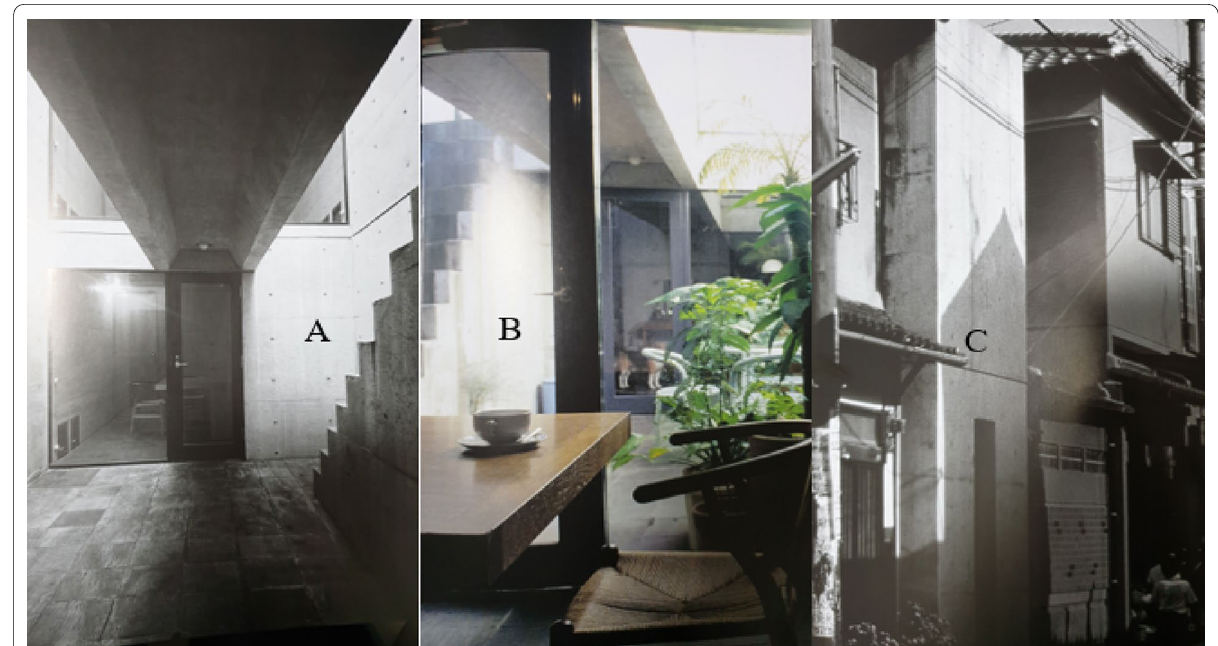
Fig. 2 Row House Sumiyoshi, Osaka, Japan ( Source: Tadao Ando: Complete Works 1975–2012 (Jodidio